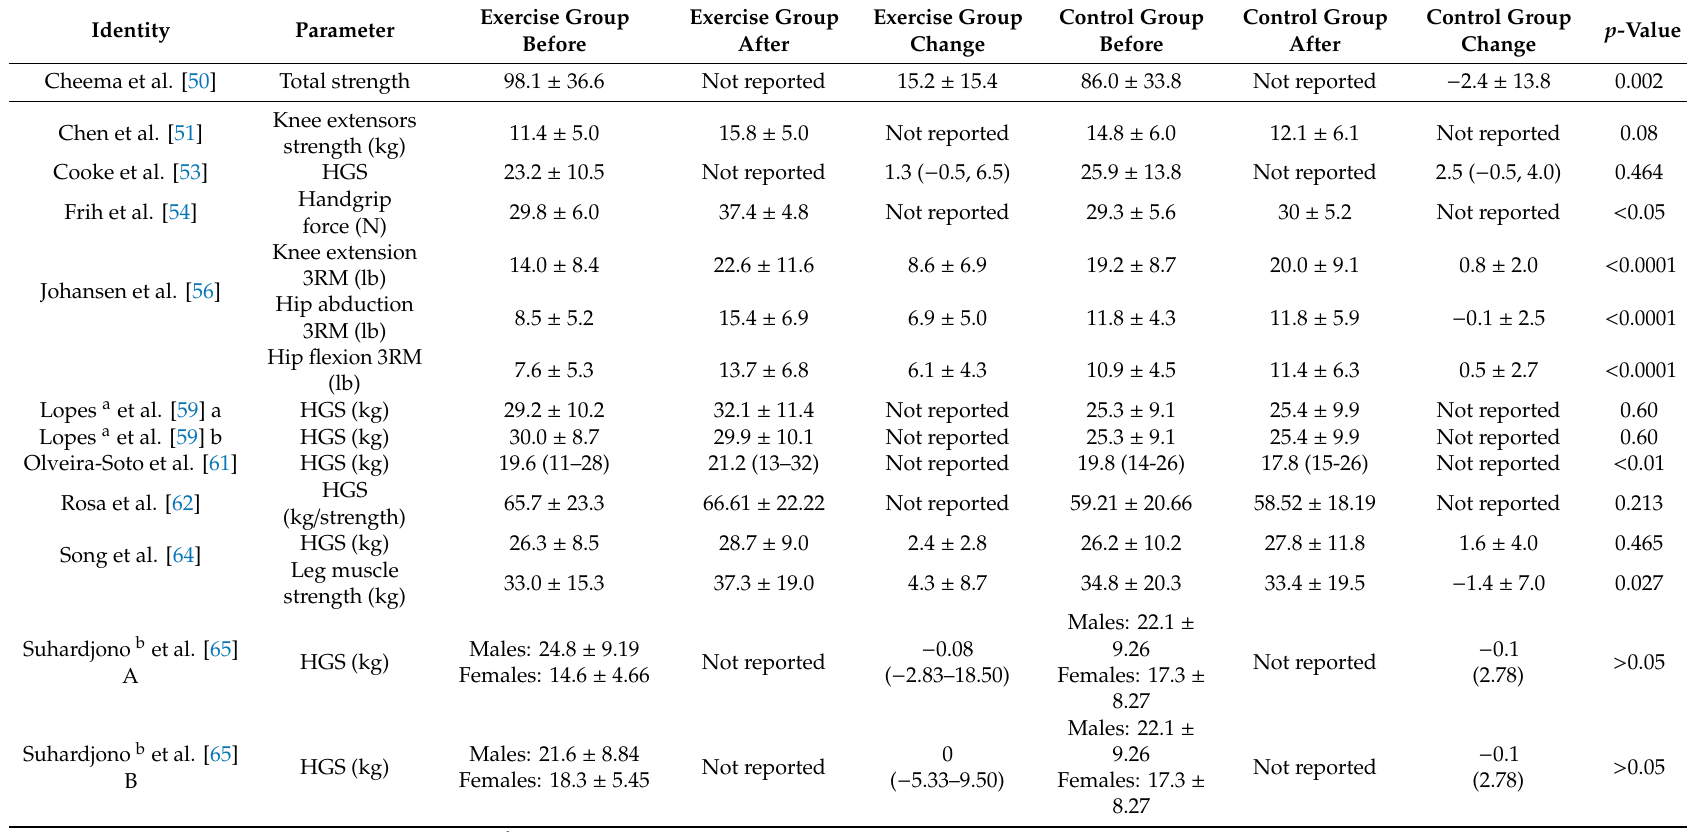
Table 8. Results of the strength